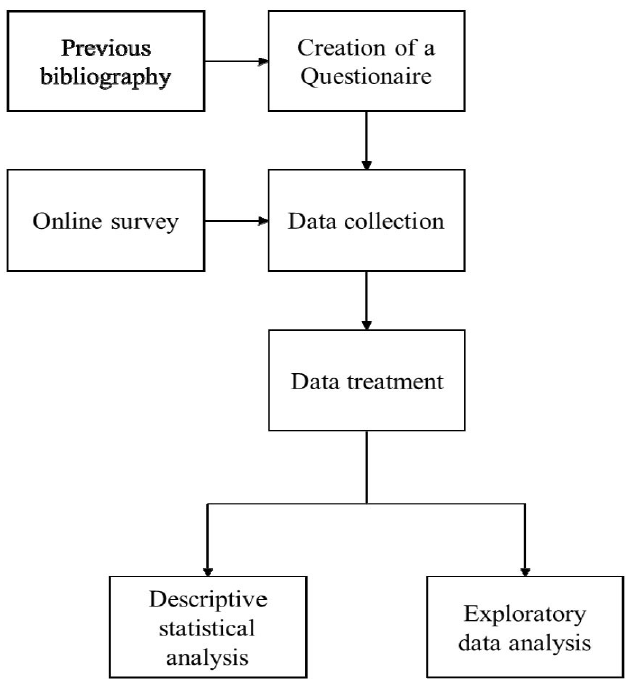
Figure 1. Research